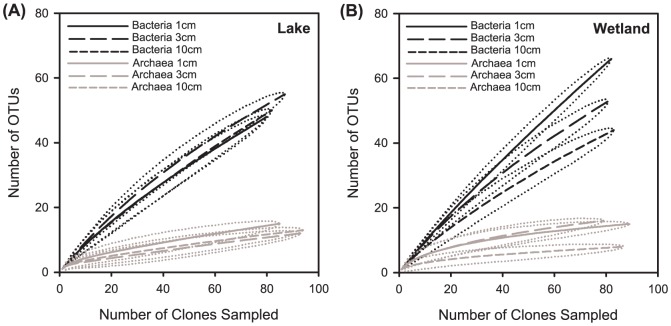
Rarefaction curves for bacterial and archaeal sequences.Results for two environments are shown: (A) lake; (B) wetland. Dotted lines represent the 95% confidence intervals, as computed by resampling in MOTHUR.